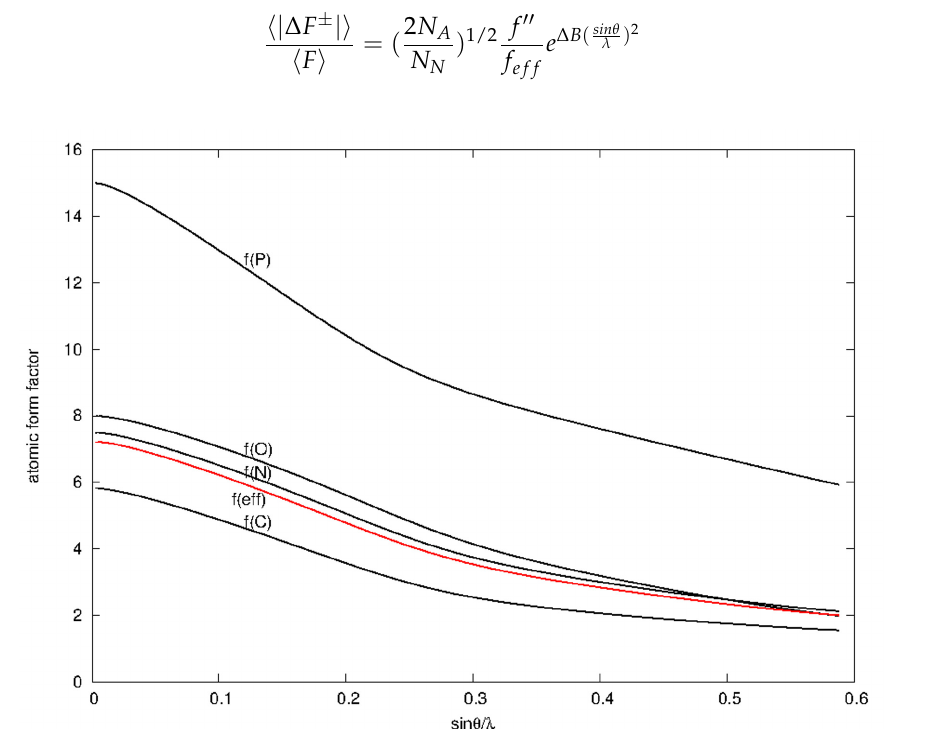
Figure 11. Plot of scattering factors calculated using Cromer-Mann coefficients in a four Gaussian approximation. The effective scattering, f(eff), is calculated by weighting the scattering factor of each element by its relative proportion to the total number of non-hydrogen atoms in